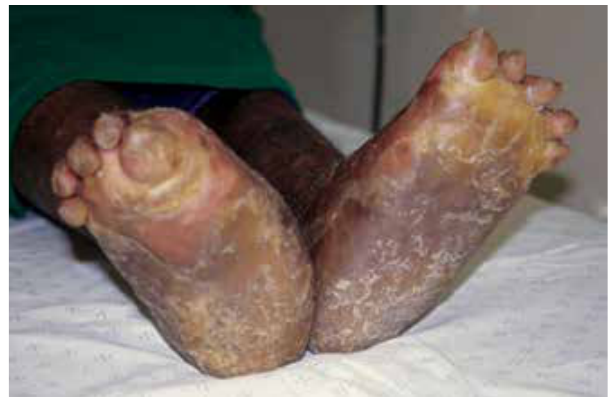
Figure 4: Severe disabling palmoplantar keratoderma